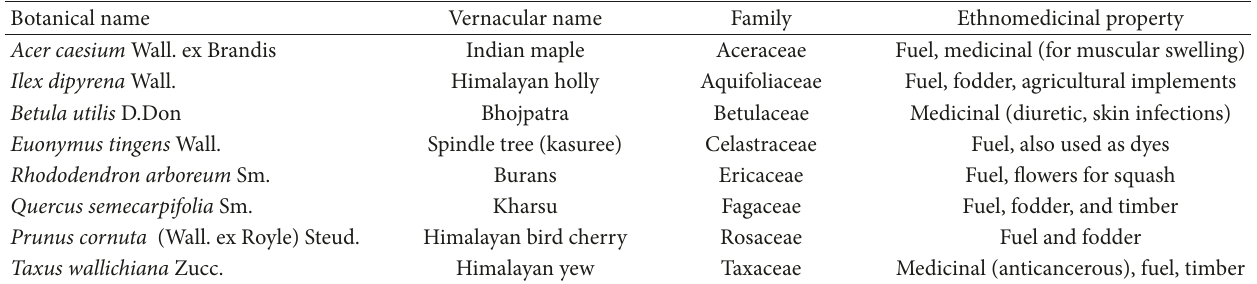
Table 7: List of Tree species (with ethnomedicinal properties) found in Tungnath SG.